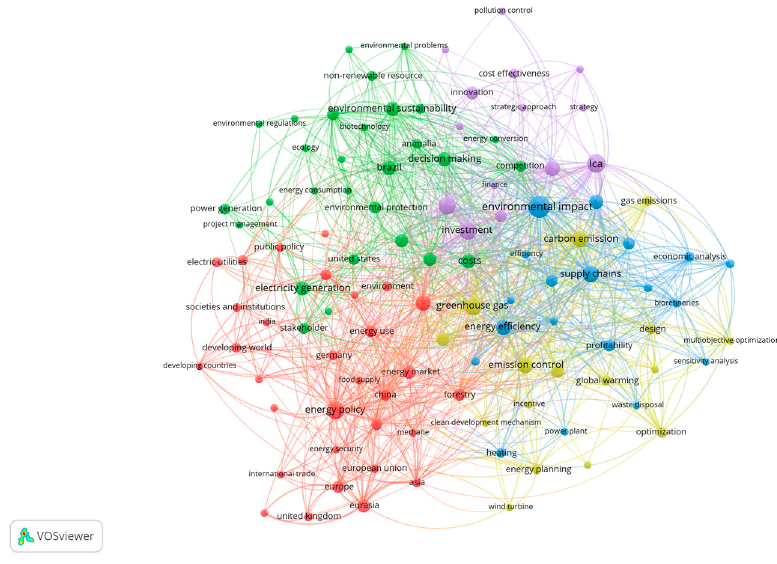
Figure 4. Network of co-occurrence keywords.